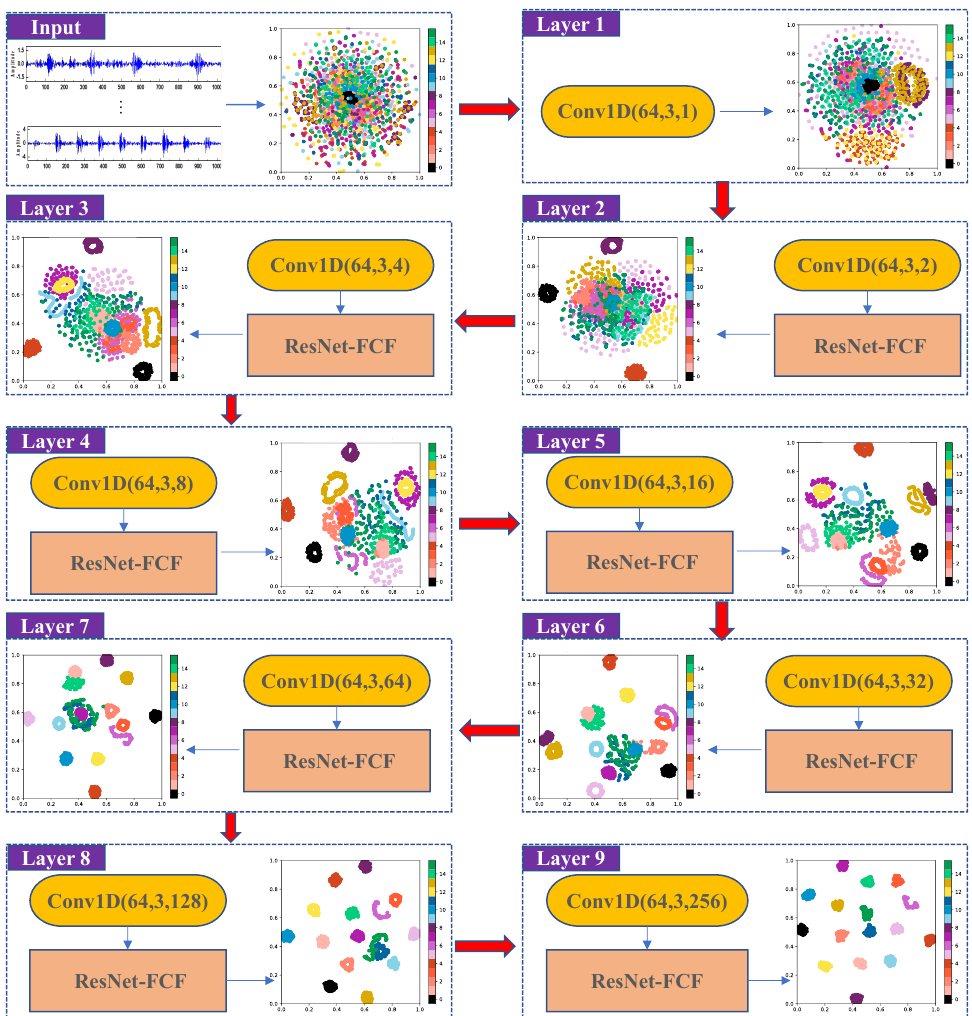
Figure 8. The proposed method fault classification